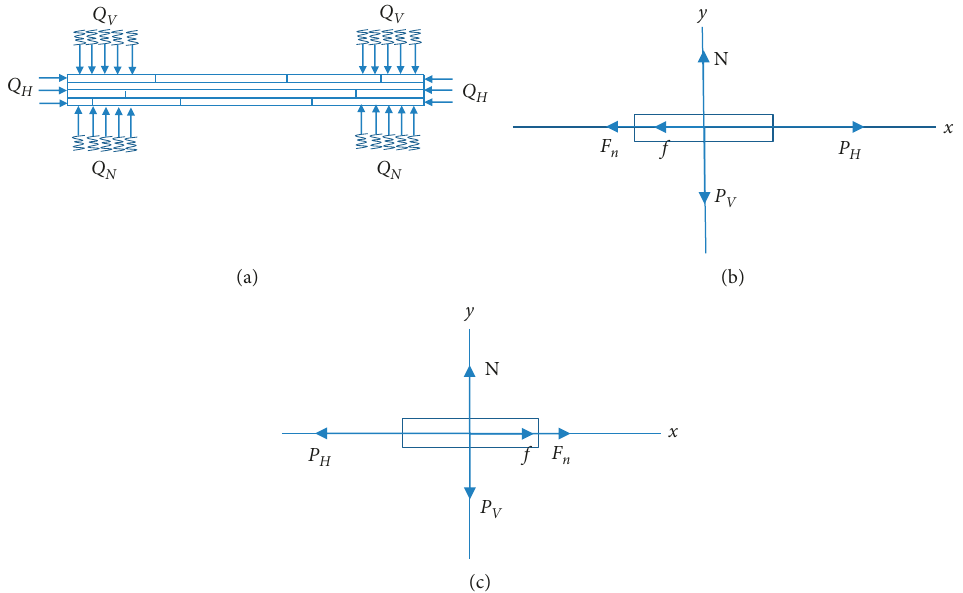
Figure 21: Diagrams of rock structural mechanics models; (a) diagram of rock structural mechanics model for the physical model; (b) diagram of rock structural mechanics model for stratum in the left of physical model; and (c) diagram of rock structural mechanics model for stratum in the right of physical